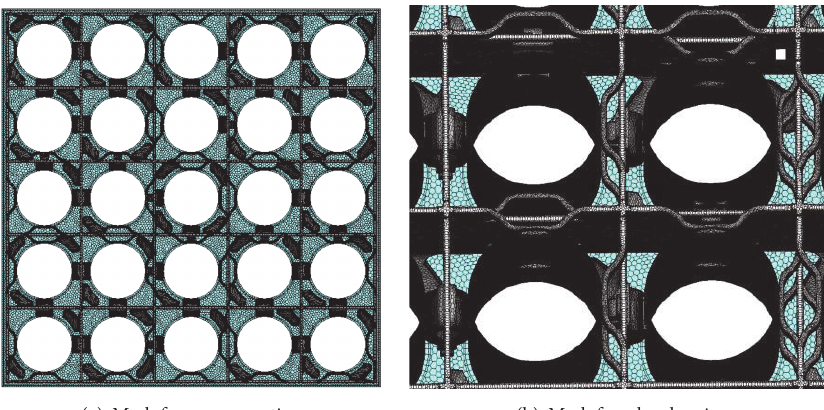
Figure 10: Mesh for 5 × 5 AFA 2G